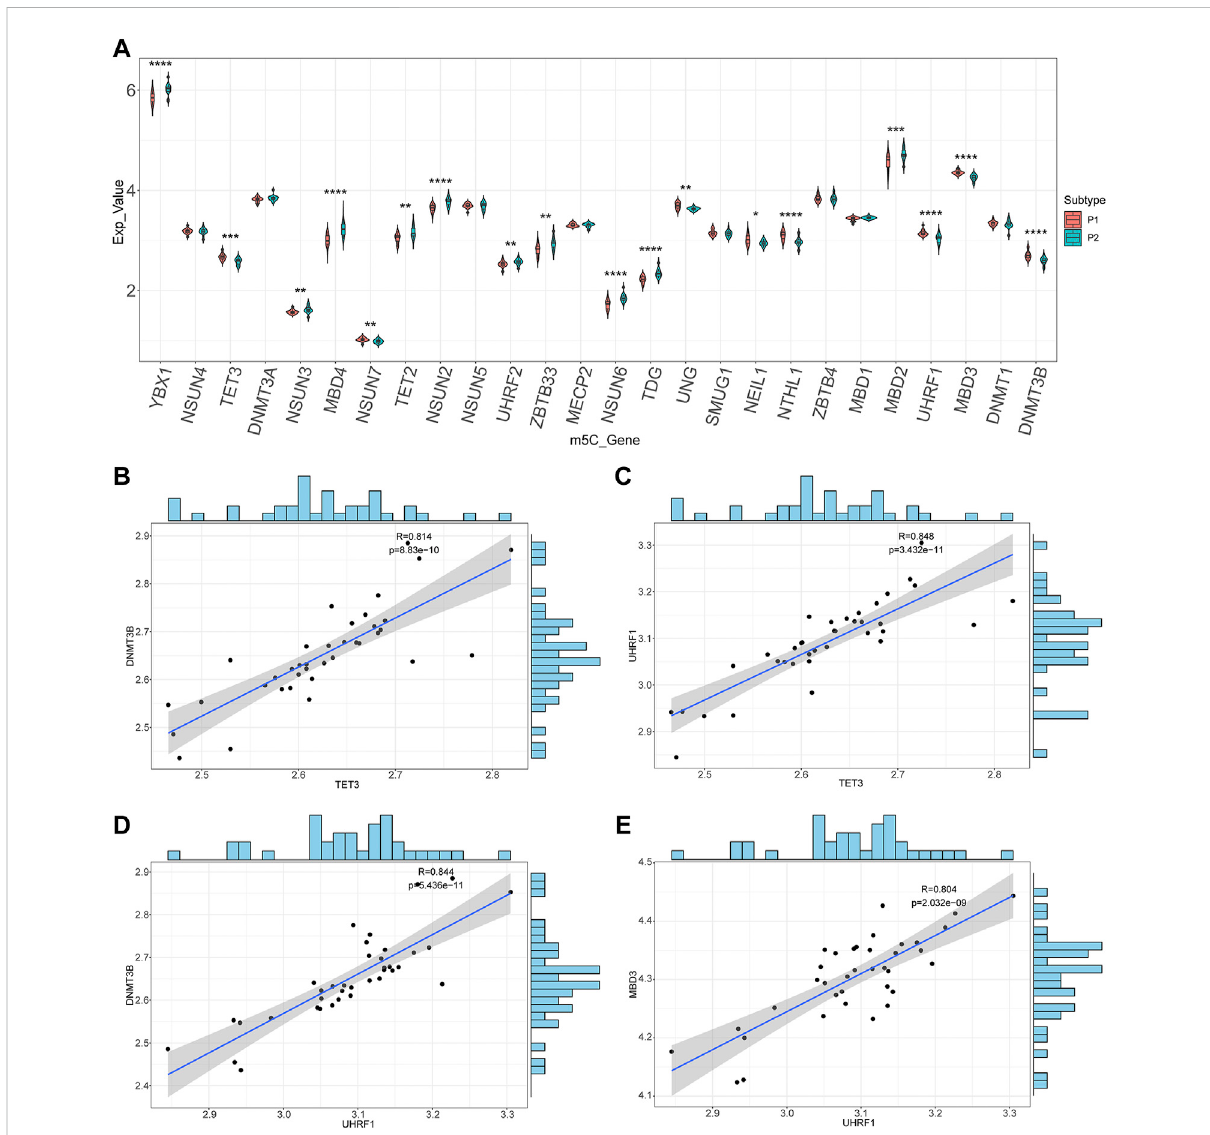
FIGURE 7 Correlations of m5C-related genes. (A) The boxplots of the m5C-related genes between two molecular subtypes. (B – E) Scatter plots and the fi tting curves of the differentially expressed m5C-related genes.